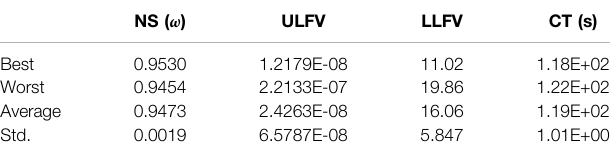
TABLE 3 | Statistical results gained by the proposed method for the benchmark test function ( “ NS ” represents the numerical solution of ω . “ ULFV ” and “ LLFV ” denotethe fi tnessvaluesoftheupperandlowerlevels,respectively. “ CT ” indicates the computation time. “ Std. ” denotes the standard deviation.).